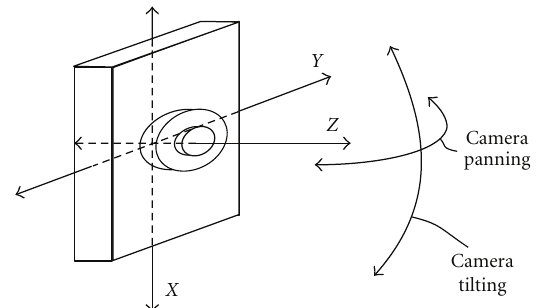
Figure 1: Camera movements and data axes used by the accelerom- eter and compass; the X -axis is perpendicular to the horizontal